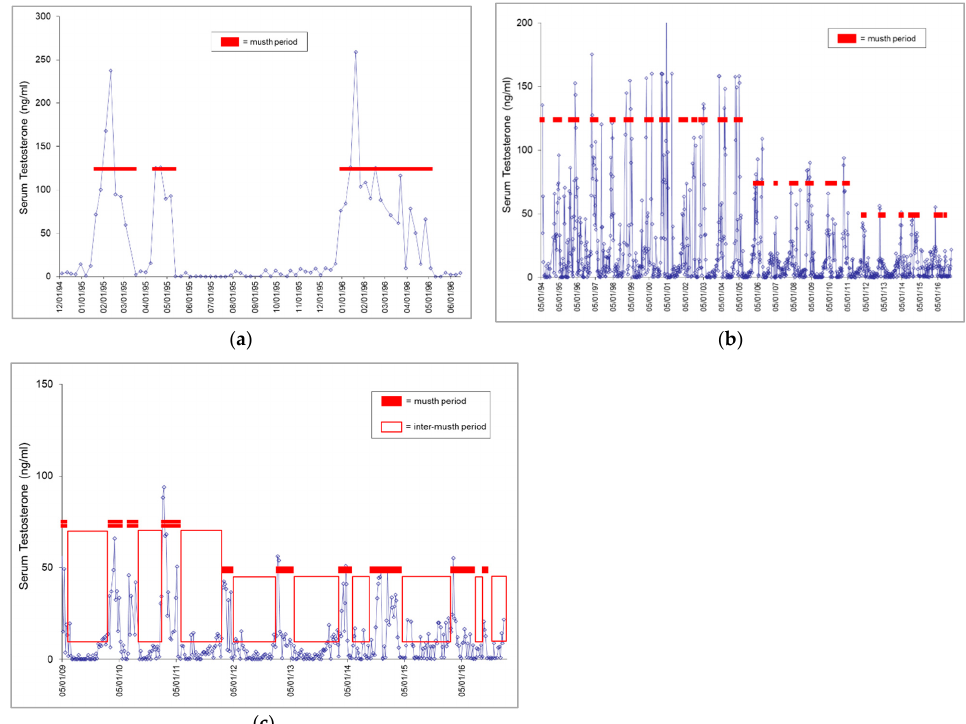
Figure 1. Patterns of testosterone during musth. ( a ) Male1: profile shows two annual musth cycles, with the first musth cycle split into two time periods occurring within the time frame of the second musth cycle; ( b ) Male2: profile shows declines in peak testosterone concentrations during musth with advancing age; ( c ) Male2: profile shows a greater percentage of time with increased testosterone during inter-musth periods from 2014 to end of life.